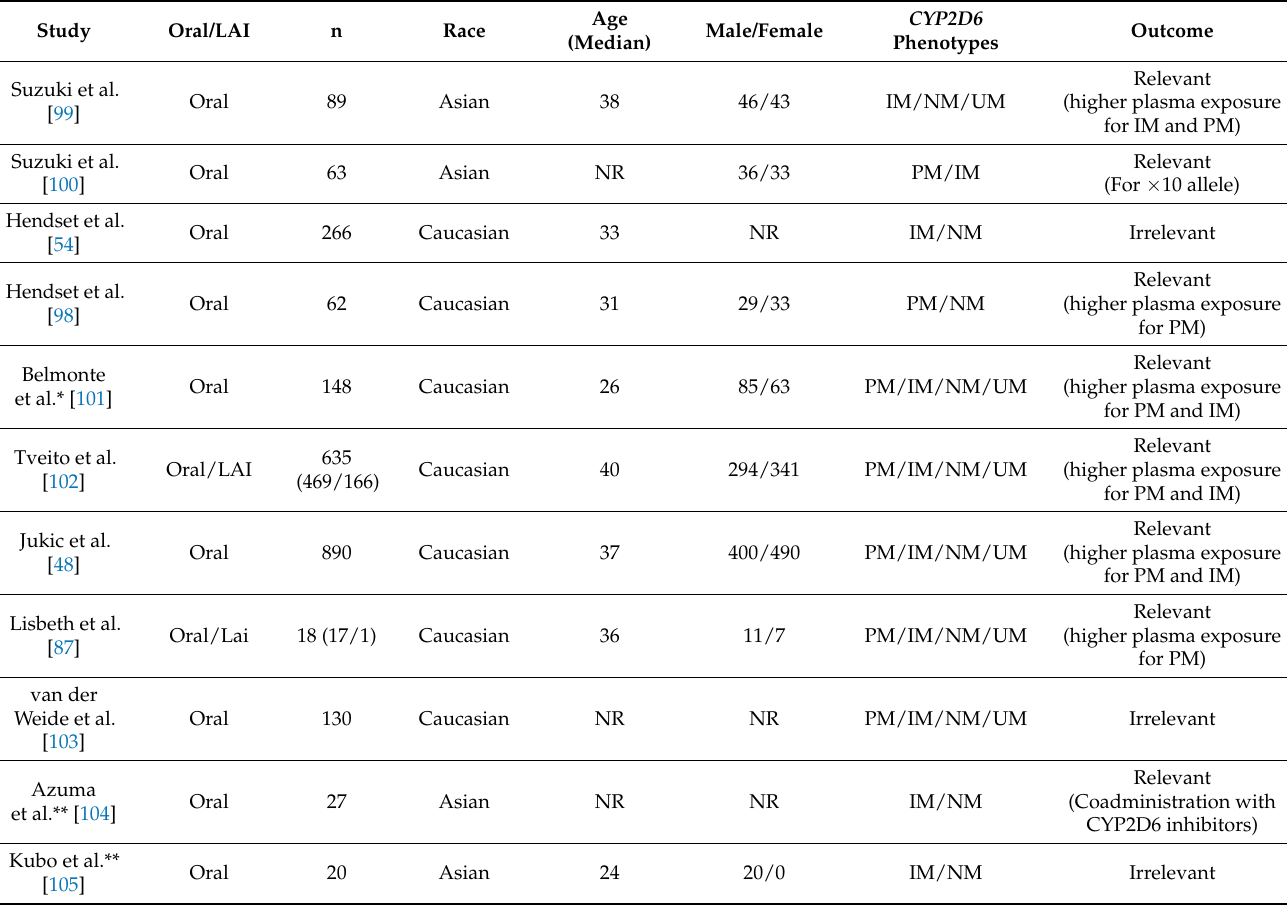
Table 7. Studies between CYP2D6 phenotype and the relation with aripiprazole plasma